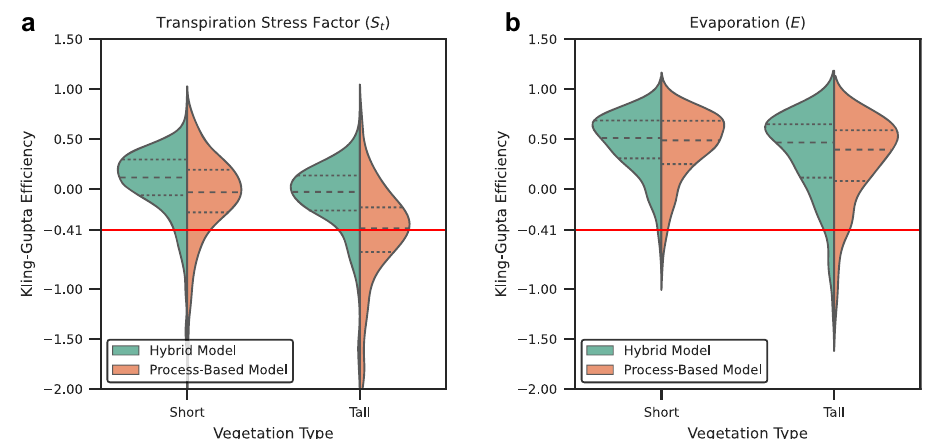
Fig. 2 Summary of in situ validation of the hybrid and process-based models. a , b Violin plots showing the distribution of the Kling-Gupta Ef fi ciency (KGE) metric for the transpiration stress factor ( S t ) and evaporation ( E ), respectively, calculated for all fl ux tower and sap fl ow measurement sites. The KGE distribution for the hybrid and process-based models are classi fi ed according to short and tall vegetation types. The dashed lines represent the median (large dashes) and the interquartile range (small dashes). The red line represents a KGE value of -0.41, above which a model prediction or simulation is considered better than the mean seasonal cycle. For the sap fl ow sites, transpiration estimates ( E t ) instead of E are used.